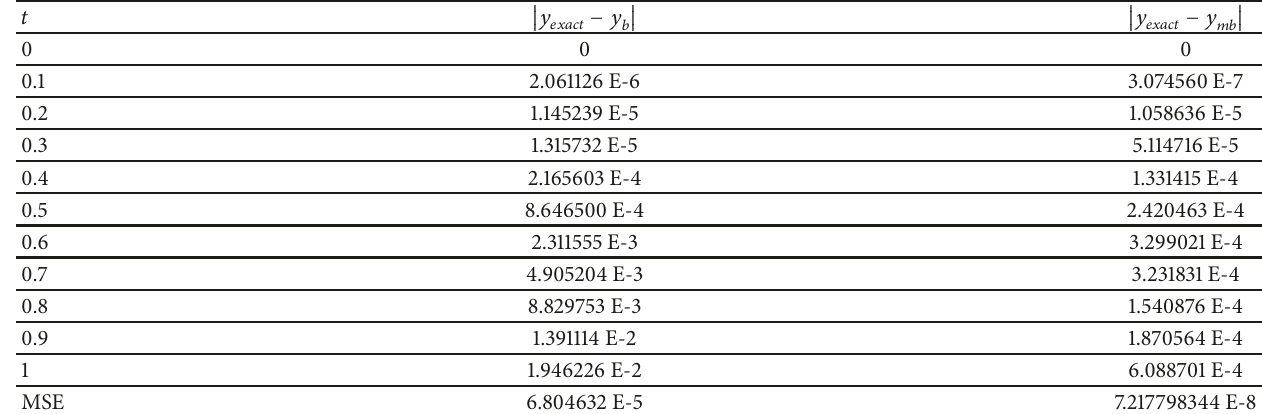
Table 2: Comparison of absolute errors using 𝑦 10 when m=16, v=4, and